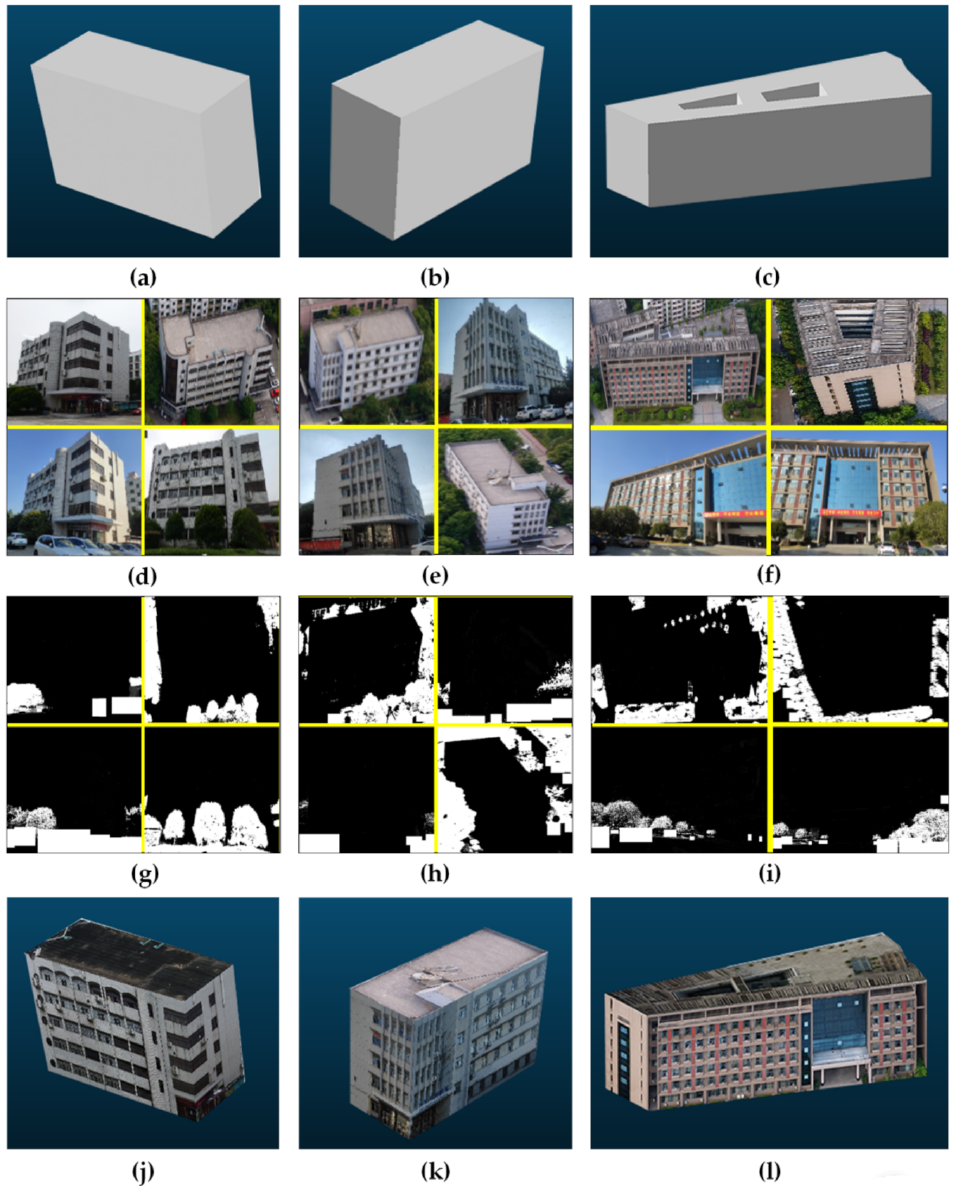
Figure 7. Typical untextured building models and the multiview texture images. ( a – c ) are three untextured building models; ( d – f ) are examples of texture images with different viewpoints corre- sponding to ( a – c ), respectively. ( g – i ) are the object occlusions, marked by white regions, detected by combining NanoDet and GGLI corresponding to ( a – c ), respectively. ( j – l ) are three textured building models by texture mapping using the proposed approach corresponding to ( a – c ),